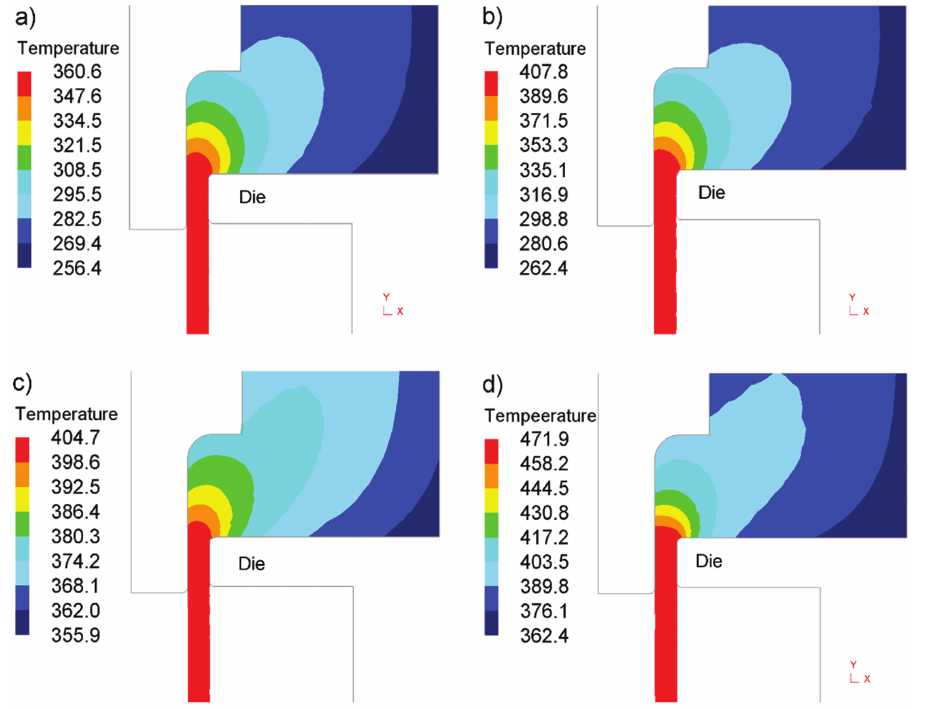
Figure 10: Distribution of temperature under different extrusion conditions: (a) 300 ℃ , 0.5mm/s; (b) 300 ℃ , 1mm/s; (c) 400 ℃ , 0.5mm/s; and (d) 400 ℃ , 1mm/s.